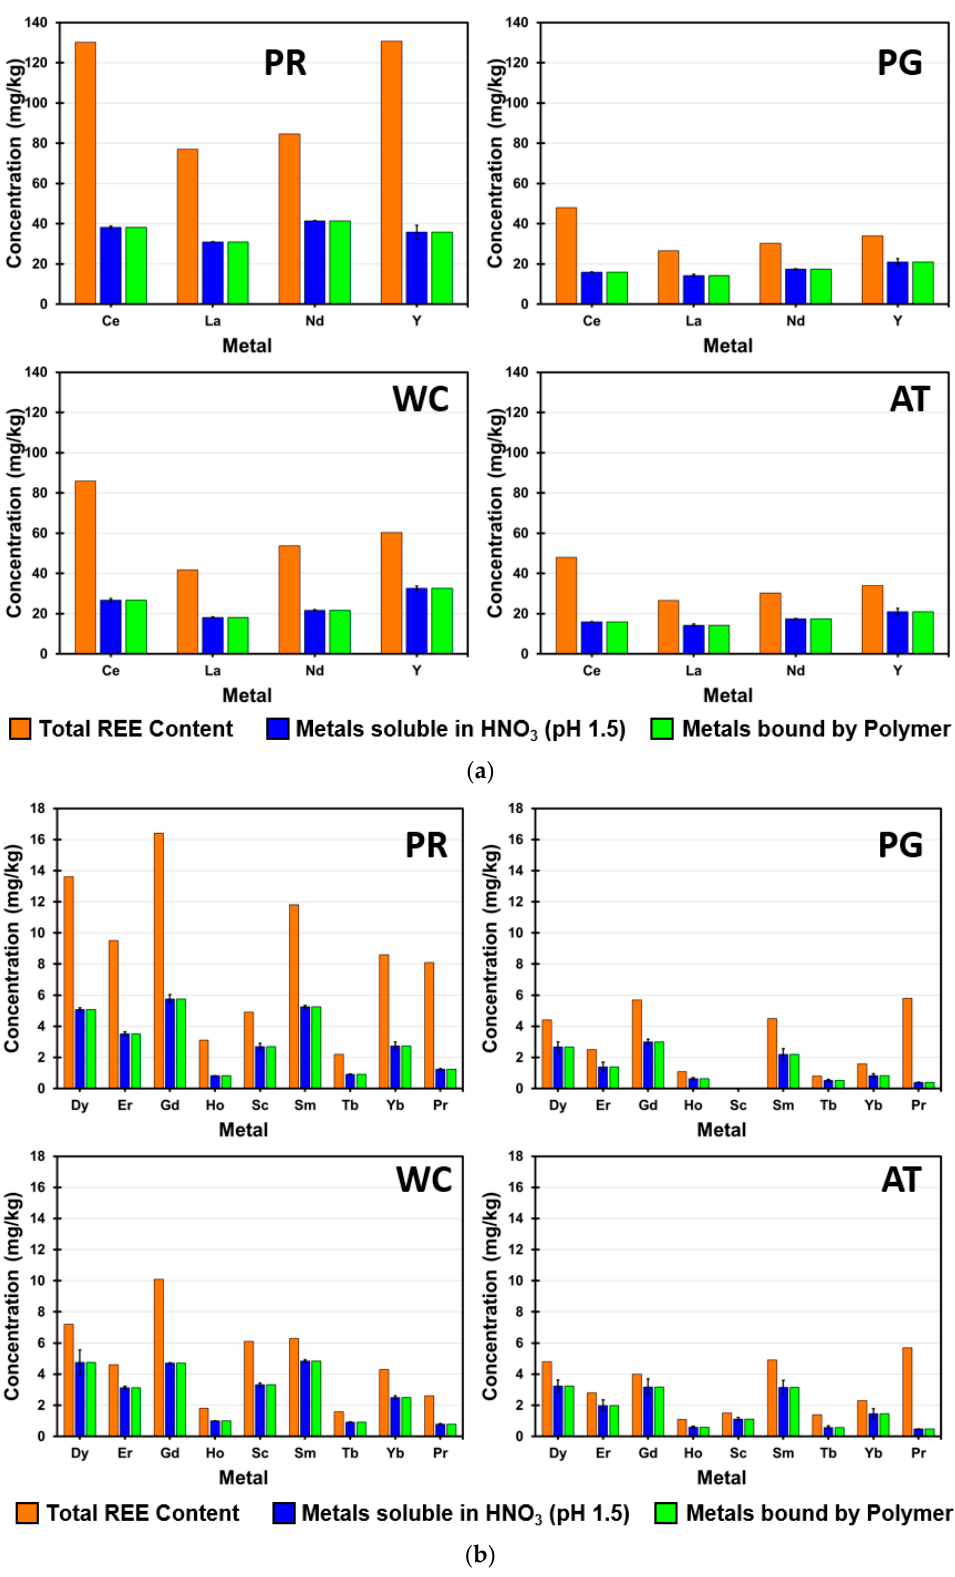
Figure 5. ( a ) High-concentration REE recovery using 1-octadecene 2,5-furandione, sodium salt, in phosphate rock (PR), phosphogypsum (PG), waste clay (WC), and amine tailings (AT). ( b ) Low-concentration REE recovery using 1-octadecene 2,5-furandione, sodium salt, in phosphate rock (PR), phosphogypsum (PG), waste clay (WC), and amine tailings (AT).